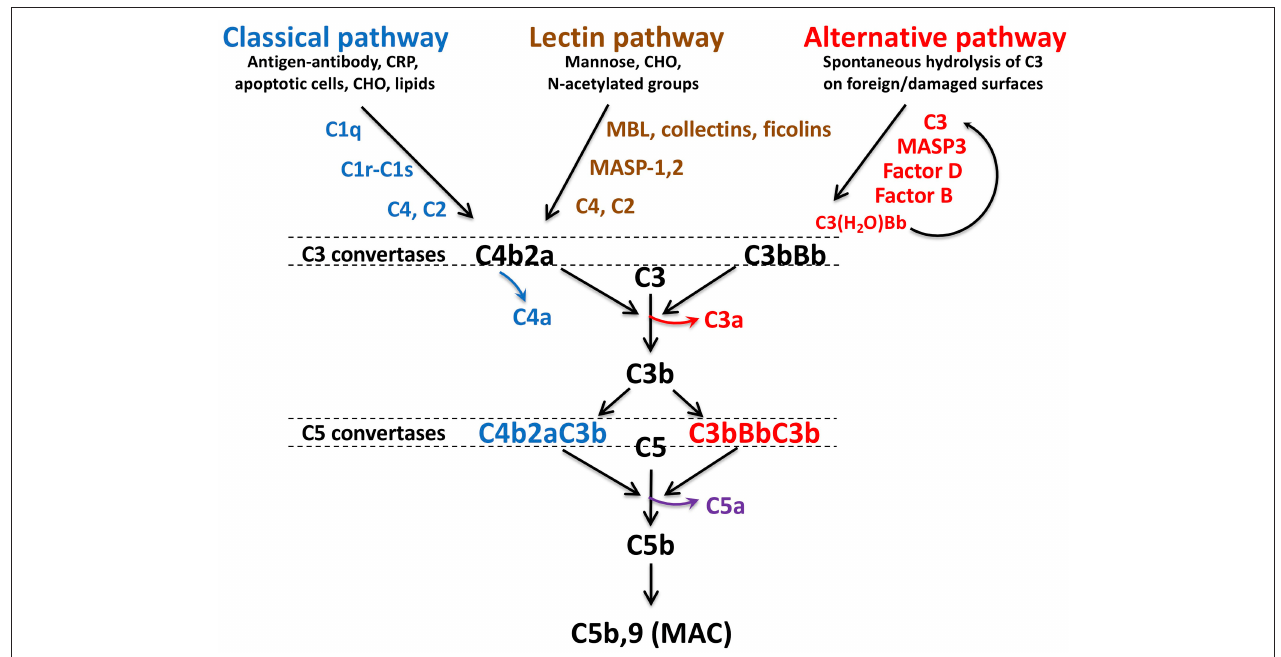
FIGURE 1 | Schematic of complement activation pathways. Complement activation proceeds via the classical, lectin, or alternative pathways, triggered by exposure of surveillance molecules, C1q, MBL, collectins and ficolins, of specific danger signals. The alternative pathway is constitutively “on,” due to spontaneous hydrolysis of C3. The pathways converge to form C3 convertases: C4b2a for the classical and lectin pathways, C3bBb for the alternative pathway. C4a and C3a, are released with cleavage of C4 and C3, respectively. As C3b is further generated, C5 convertases C4bBbC3b and C3bBbC3b are formed, resulting in liberation of the most potent anaphylatoxin C5a, in conjunction with C5b. C5b is the initial component required for spontaneous assembly of the C5b-9 membrane attack complex (MAC) which polymerizes and induces lysis of the cellular target. MBL, mannose binding lectin, CRP, C-reactive protein, CHO, carbohydrate, MASP, MBL associated serine protease. Figure and legend from Conway